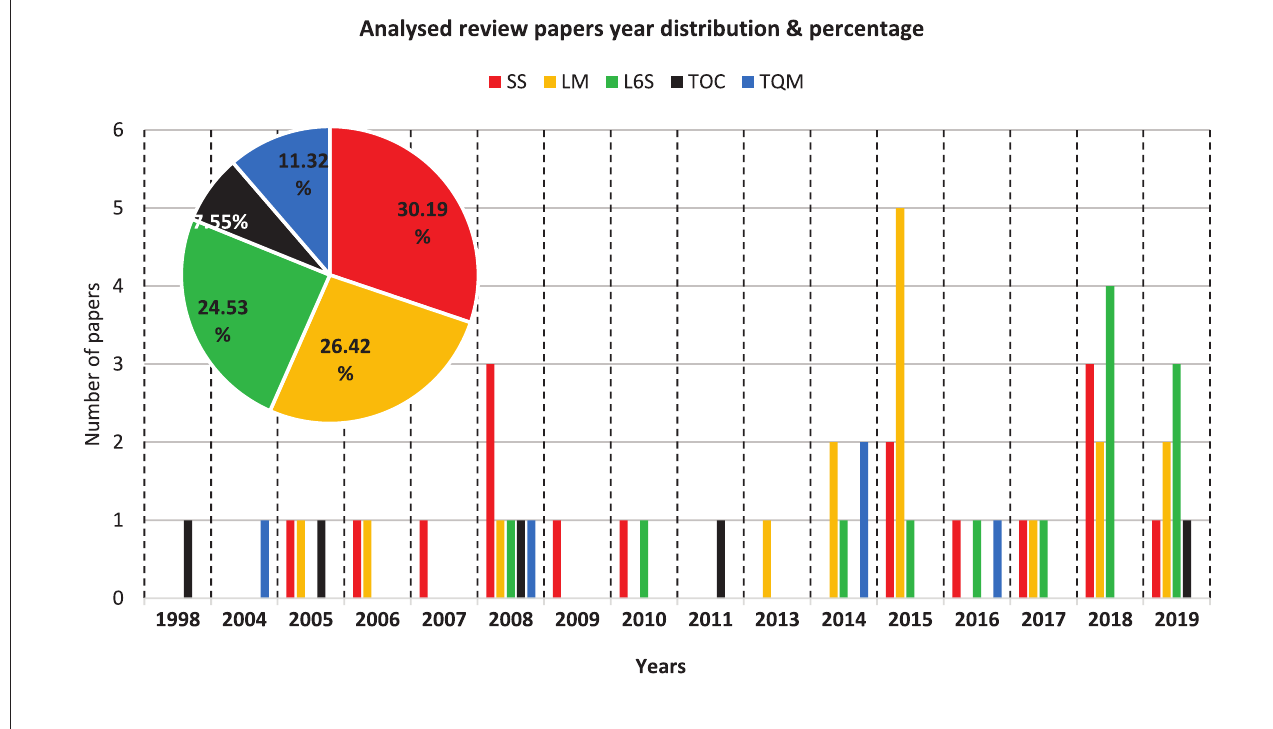
FIGURE 1 | Distribution of the philosophy focus regarding the